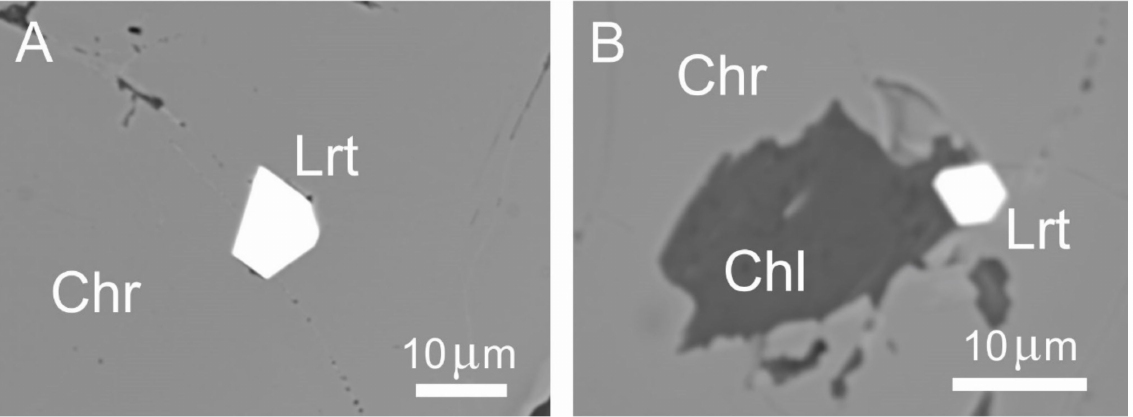
Figure 11. BSE images of polygonal laurite associated with the high-Al chromitites of Sebuku Island showing a single grain enclosed in chromite crystals ( A ), and in contact with chlorite ( B